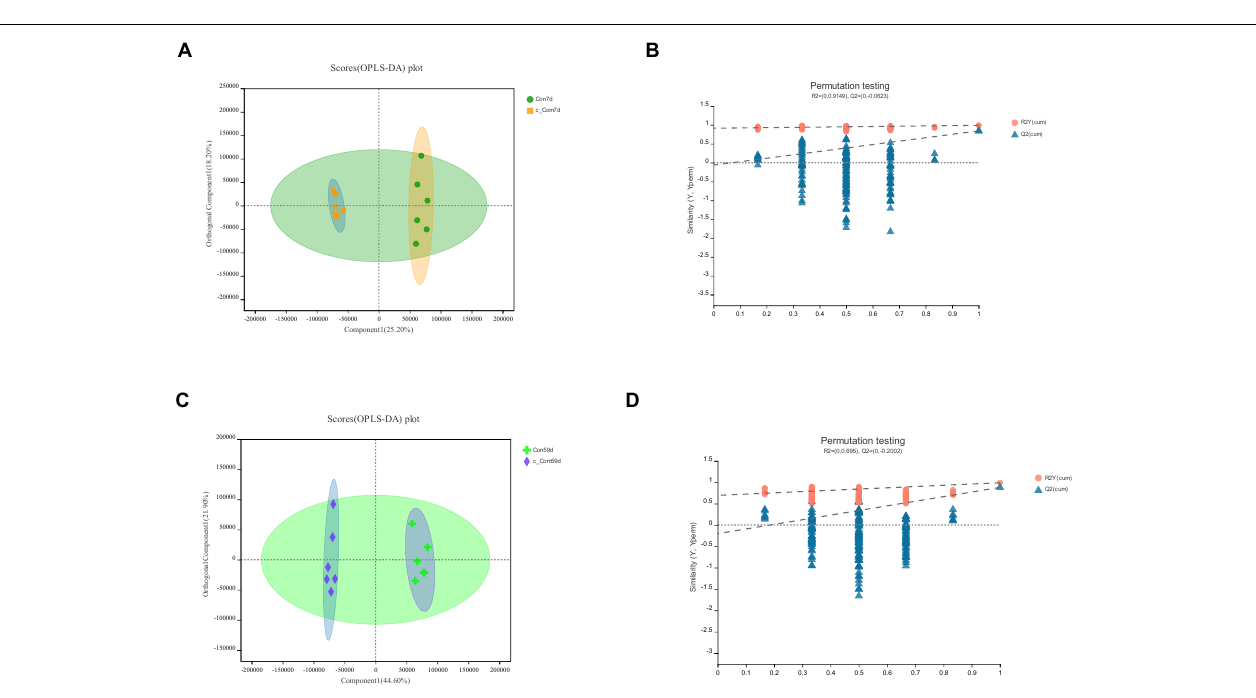
FIGURE 5 | In c-Com vs. Con, panels (A,B) for 7th day and panels (C,D) for 59th day. Panels (A,C) are OPLS-DA scores plot. Panels (B,D) are OPLA-DA permutation tests. (B) R 2 X (cum) = 0.558, R 2 Y (cum) = 0.991, Q 2 = 0.844. (D) R 2 X (cum) = 0.665, R 2 Y (cum) = 0.99, Q 2 = 0.881.